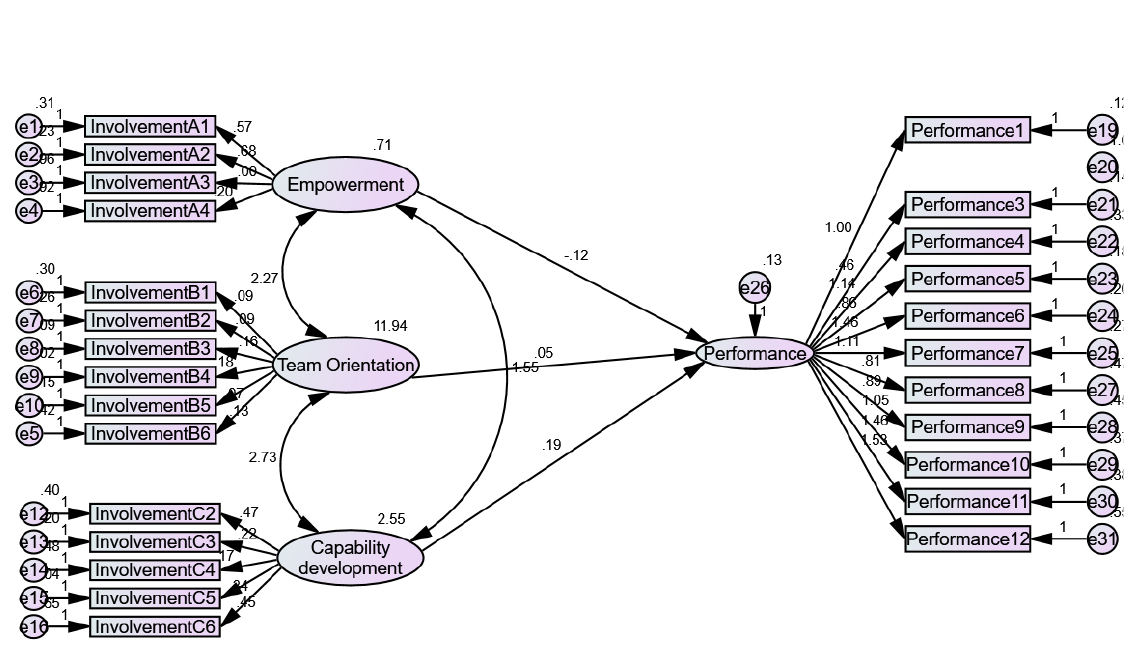
Figure 1: Path diagram for the structural model on the effect of involvement on performance